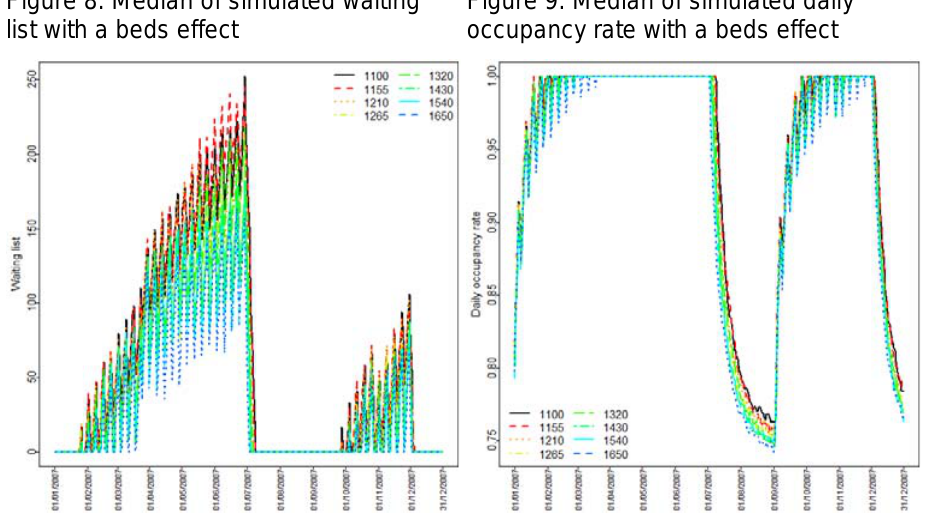
Figure 8. Median of simulated waiting Figure 9. Median of simulated